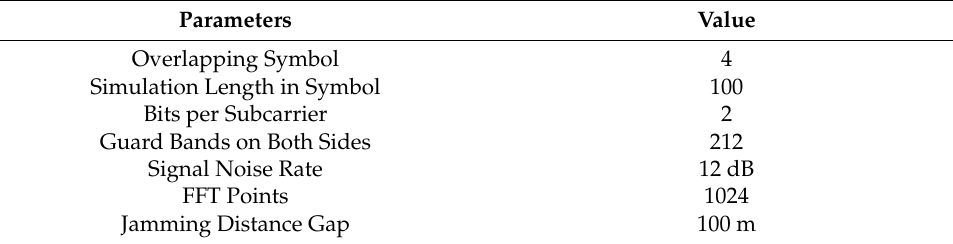
Table 3. Joint system parameter